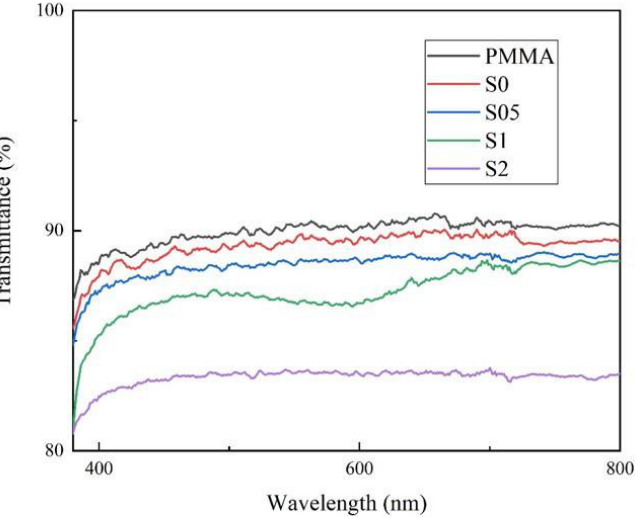
Table 2. hardness and adhesion levels of PMMA and coatings .